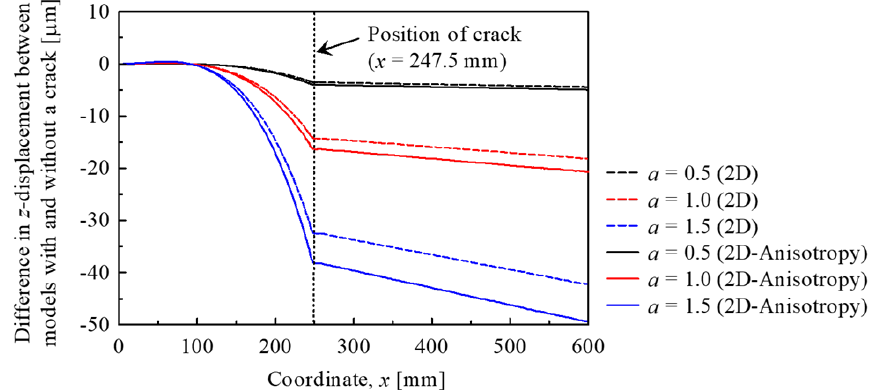
Figure 8. The di ff erence in the z -displacement between the models with and without a crack of Figure 8. The difference in the z -displacement between the models with and without a crack of Model Model 2D-Anisotropy.